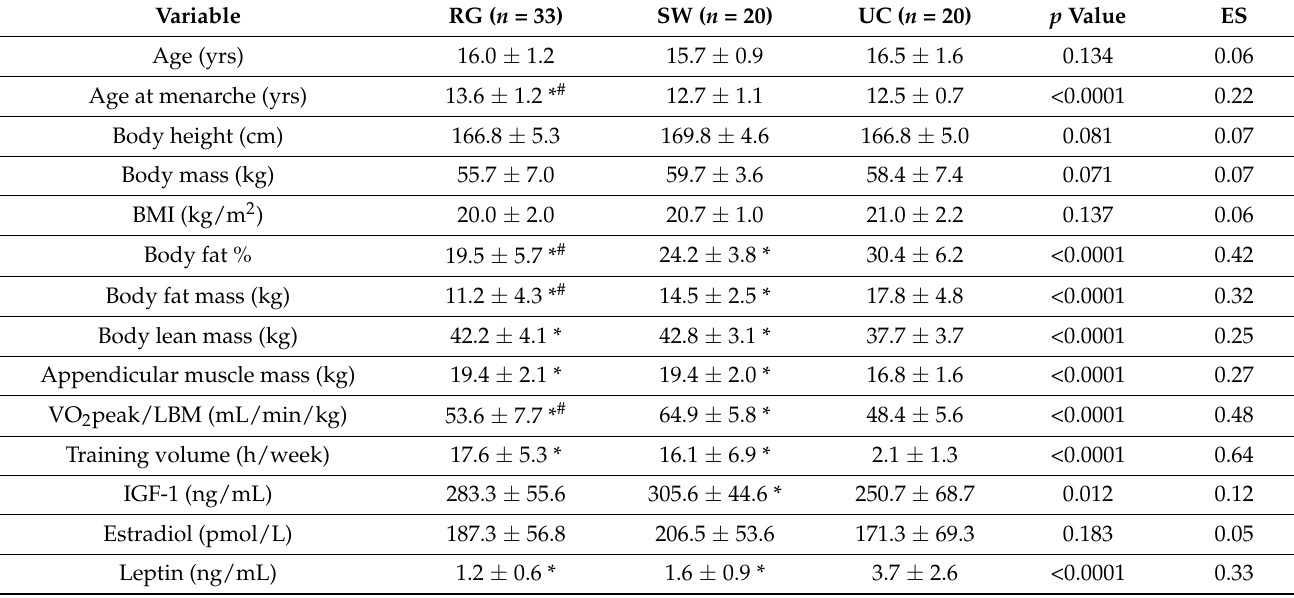
Table 1. Mean ( ± SD) characteristics of rhythmic gymnasts (RG), swimmers (SW) and untrained controls (UC).